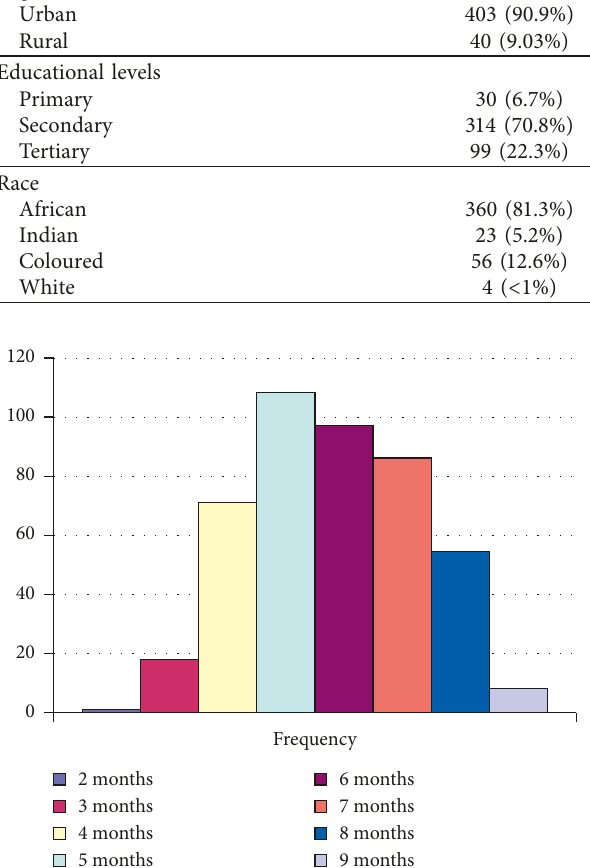
Figure 1: Gestational stage distribution of the study population.